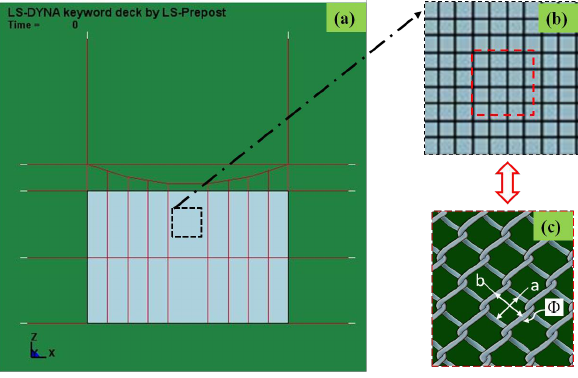
Figure 5. The wire-net in an LPR system. (a) Numerical model of the R-LPR, where wire-net 2 Fig. 5. The wire-net in an LPR system. (a) Numerical model of is modelled equivalently by continuum (shell) finite elements; due to very dense grid of 50 3 the R-LPR, where wire-net is modelled equivalently by continuum mm x 50 mm, the discretization is not seen. (b) Zoomed view of the shell element-mesh 4 (shell) finite elements; due to very dense grid of 50mm × 50mm, cropped from the former model. (c) Schematic drawing of the woven wire-net (mesh) in 5 the discretization is not seen. (b) Zoomed view of the shell element- reality; where the mass per unit area, for given mesh size such as (a x b) and material, are 6 mesh cropped from the former model. (c) Schematic drawing of specified as per the diameter (  ) of the consituting wires; e.g., 4.6 kg/m 2 for 50 x 50 x 4 mm 7 the woven wire-net (mesh) in reality; where the mass per unit area,  , and 7.1 kg/m 2 for 50 x 50 x 5mm  . 8 for given mesh size such as ( a × b ) and material, are specified as per the diameter ( 8 ) of the constituting wires; e.g. 4.6kgm − 2 for